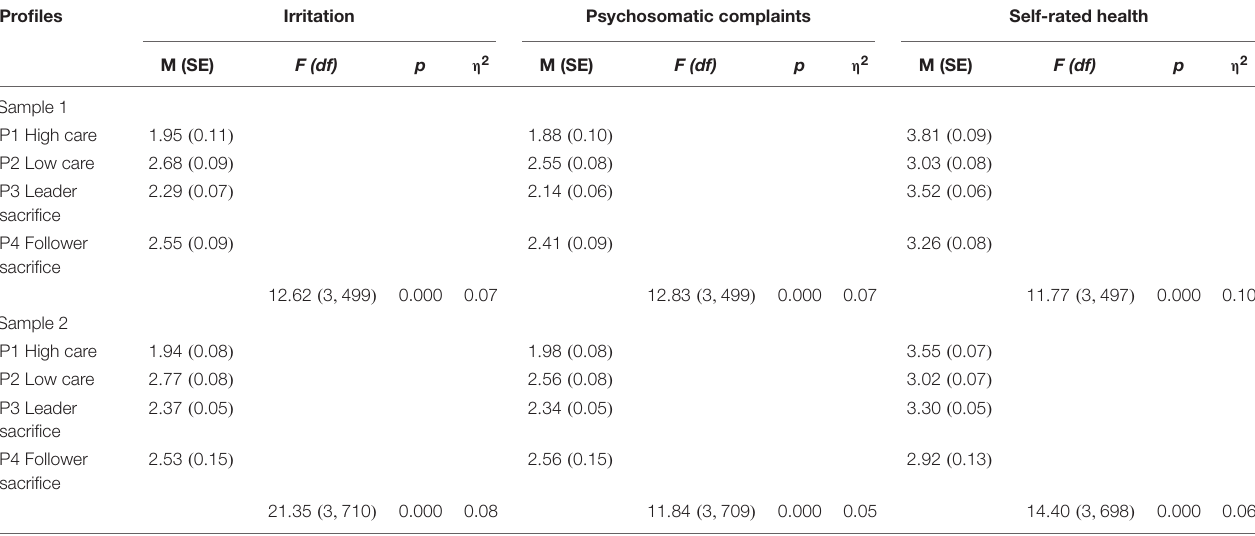
TABLE 3 | Descriptive statistics and ANCOVA of health indicators across profiles, controlling for gender and age.